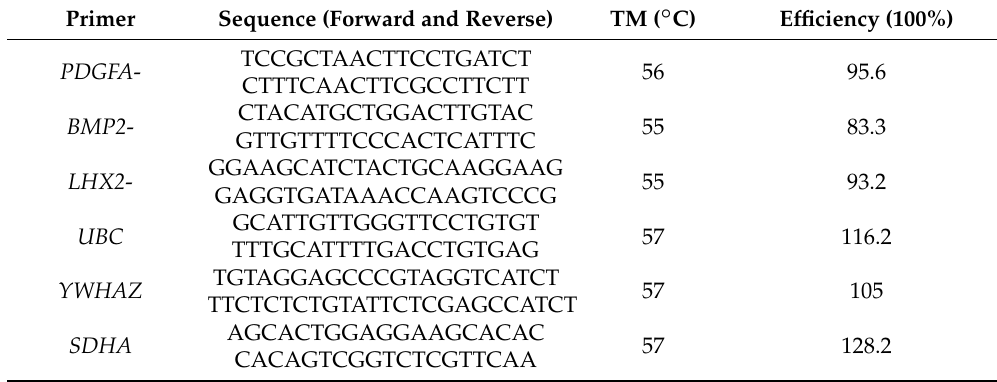
Table 2. Primer designed for Real-Time PCR with Efficiency.